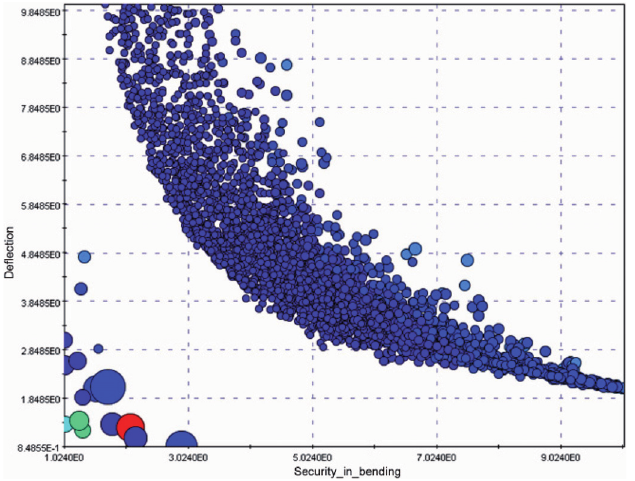
Fig. 8. Admissible solutions in the criteria space: deflection / safety in bending.